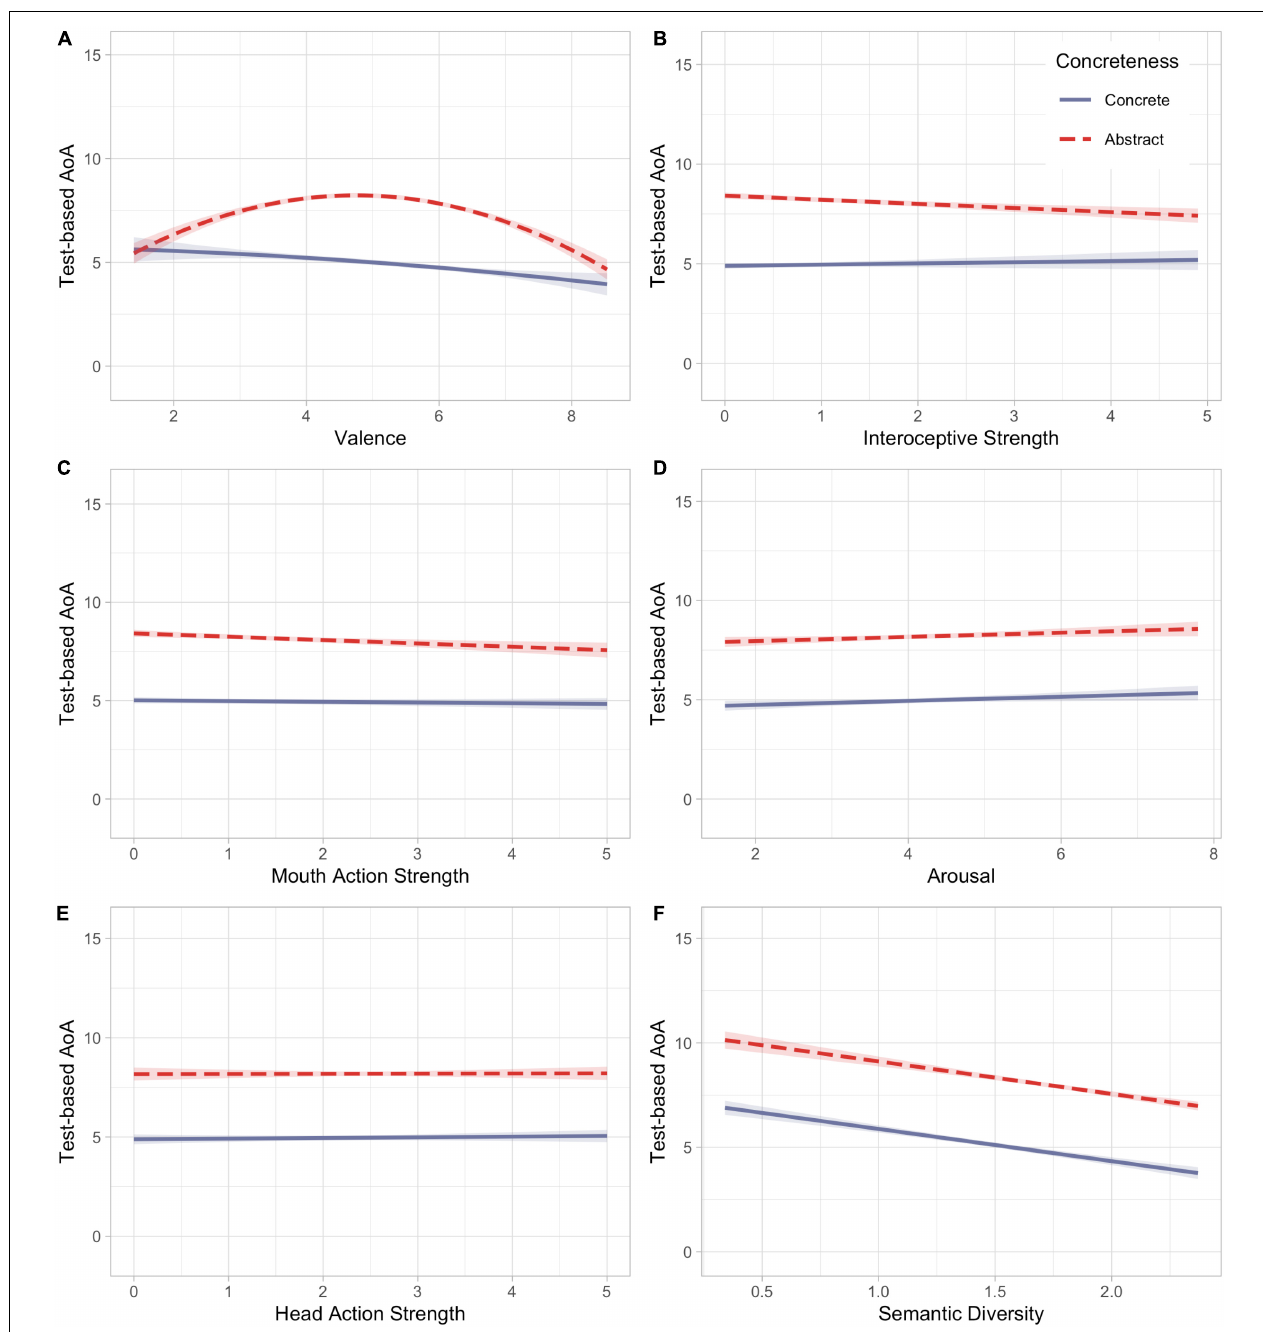
FIGURE 1 | AoA, Age of Acquisition. Plots depict partial residuals of the interaction between concreteness and (A) Valence, (B) Interoceptive Strength, (C) Mouth Action Strength, (D) Arousal, (E) Head Action Strength and (F) Semantic Diversity in predicting AoA. All plots represent the interaction relationship when other variables in the model are held